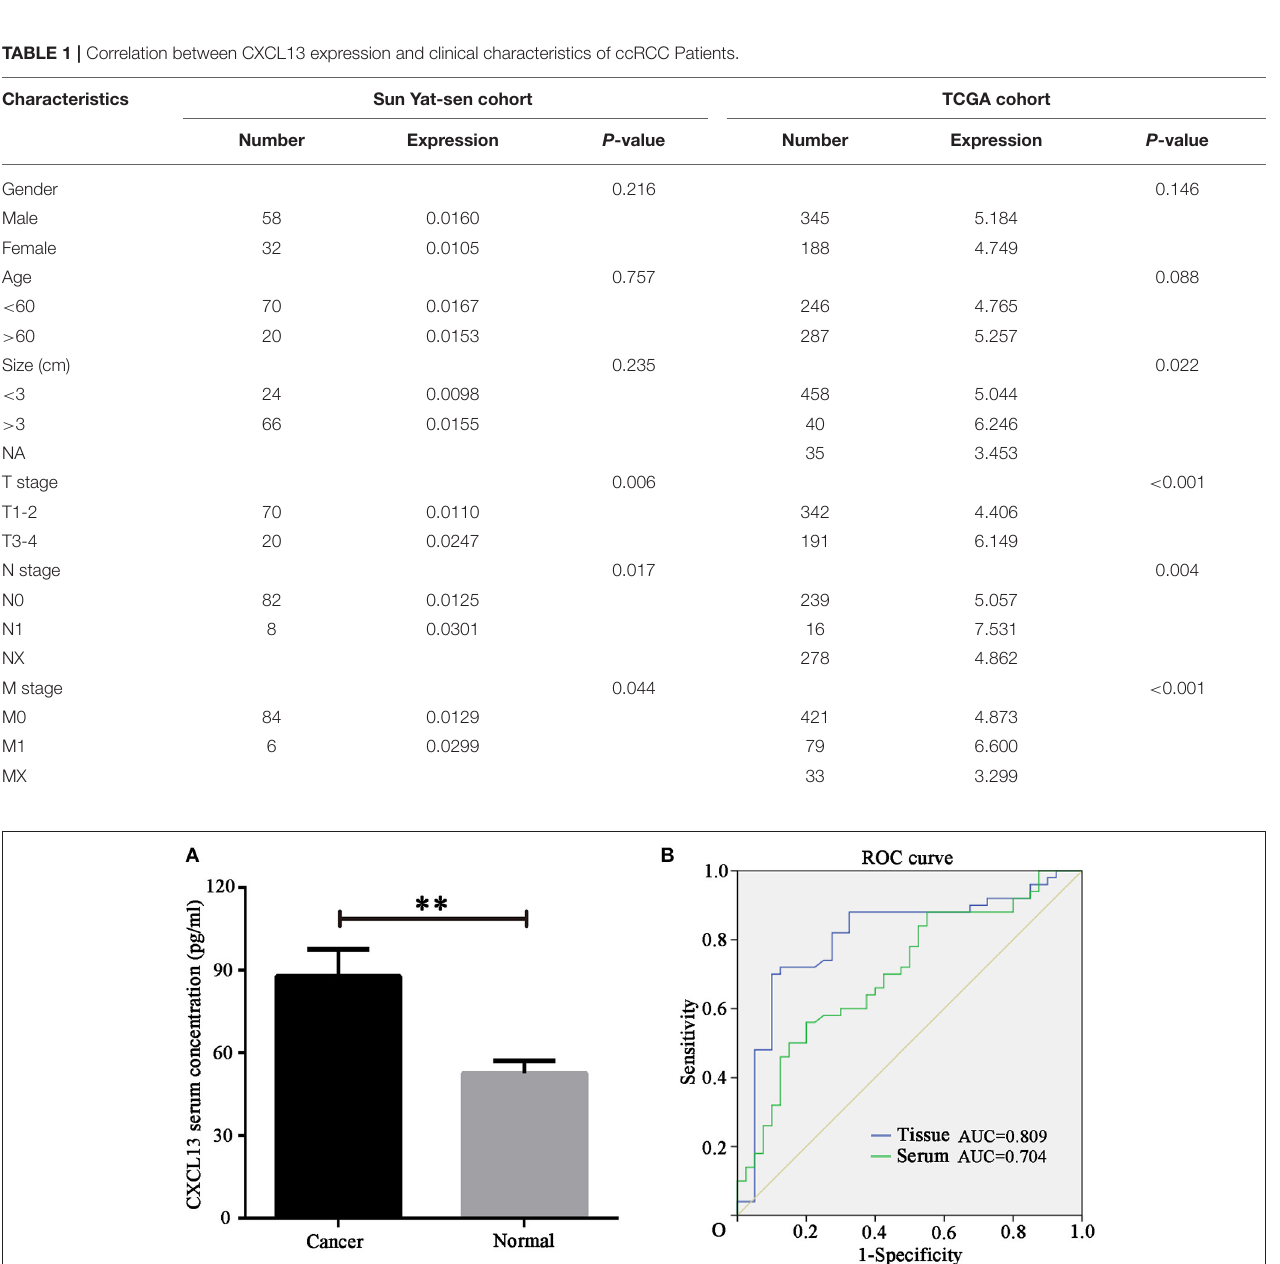
FIGURE 3 | CXCL13 might be a diagnostic marker in ccRCC. (A) Serum CXCL13 level was determined with ELISA kit in ccRCC patients and healthy volunteers. Serum CXCL13 level was significantly higher in ccRCC patients than in healthy volunteers (Student’s t -test, ** P < 0.01). (B) ROC curve analysis of the diagnostic value of tissues and serum CXCL13 expression in ccRCC